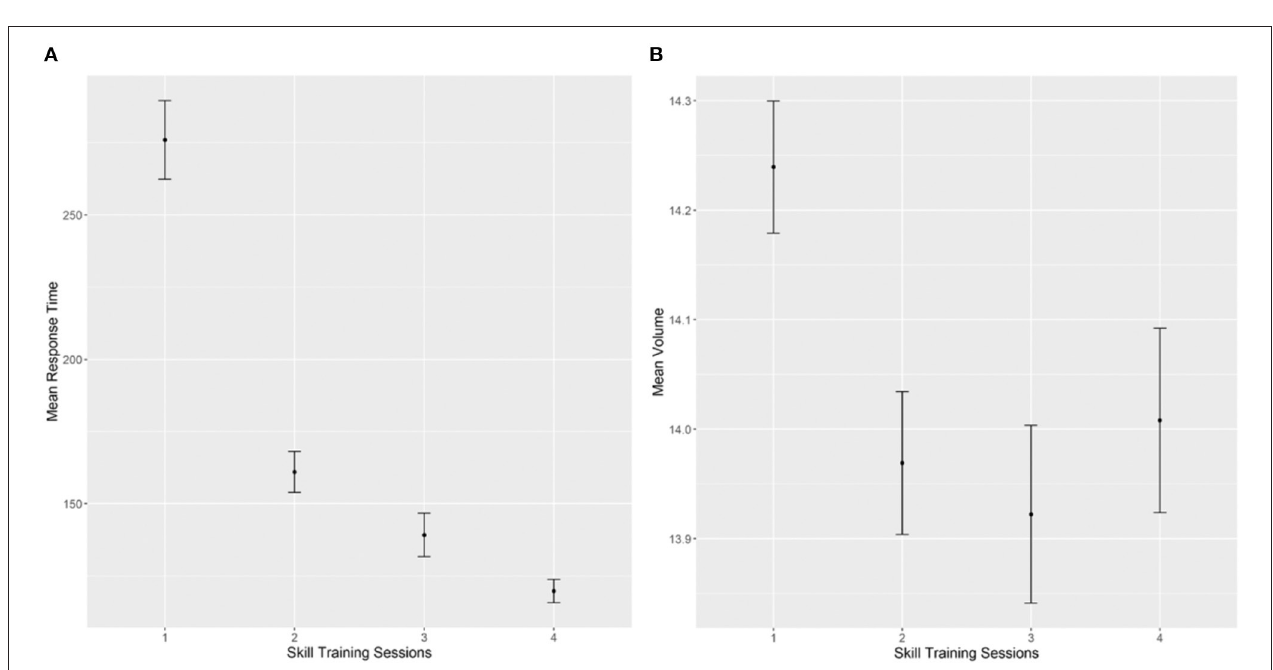
FIGURE 5 | Performance outcomes of the peg transfer task across the laparoscopic skill training sessions. (A) Mean reaction time data (in seconds) across training sessions. (B) Mean log transformed volume data (mm 3 ) across training sessions. Error bars represent standard errors of the means.